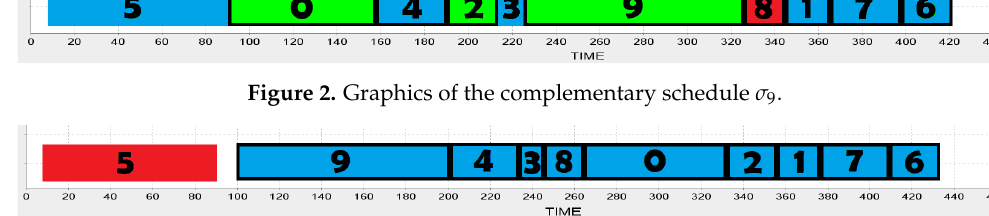
Figure 3. The optimal solution for instance